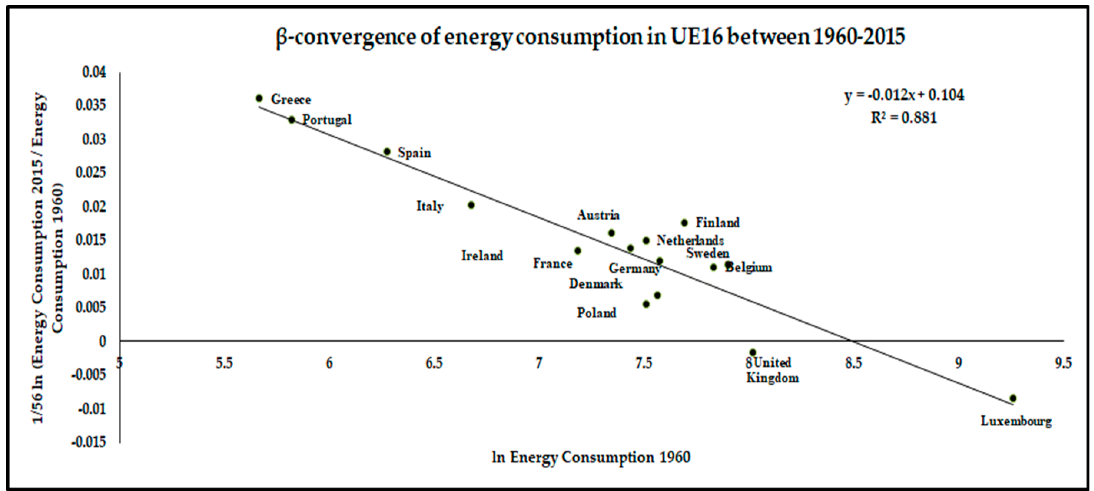
Figure 1. β -convergence of energy consumption in UE16 1960–2015 (Model 1).